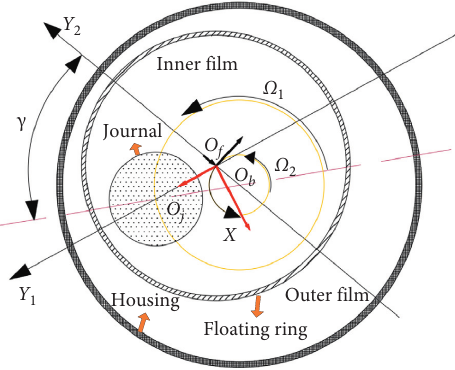
Figure 1: DCSFD structure scheme.